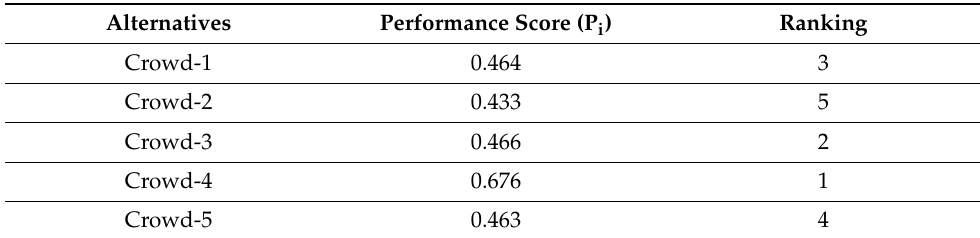
Table 11. P i and ranking of